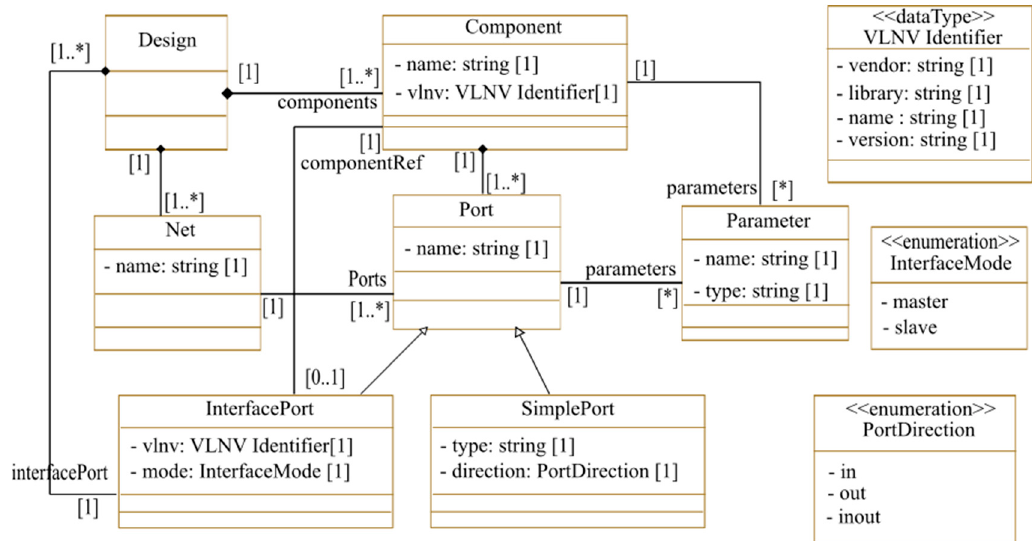
Figure 5. Xilinx Block Design eta-model , (* UML Syntax that means zero or more).